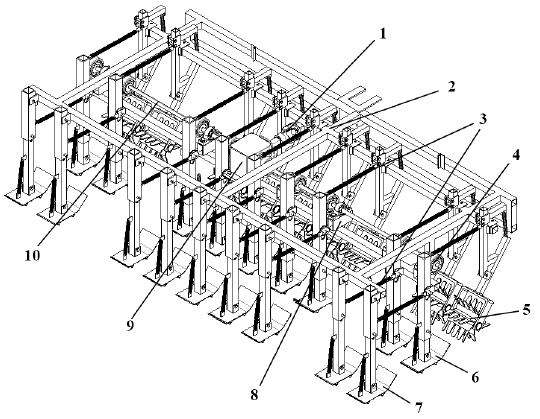
Figure 1. Overall structure of reciprocating inter-row paddy weeding machine for strip-seeded rice. 1. Power input shaft 2. Frame 3. Spring 4. Eccentric wheel 5. Rake weeding wheel 6. Front weeding shovel 7. Rear weeding shovel 8. Soleplate 9. Transmission box 10. Transmission shaft.